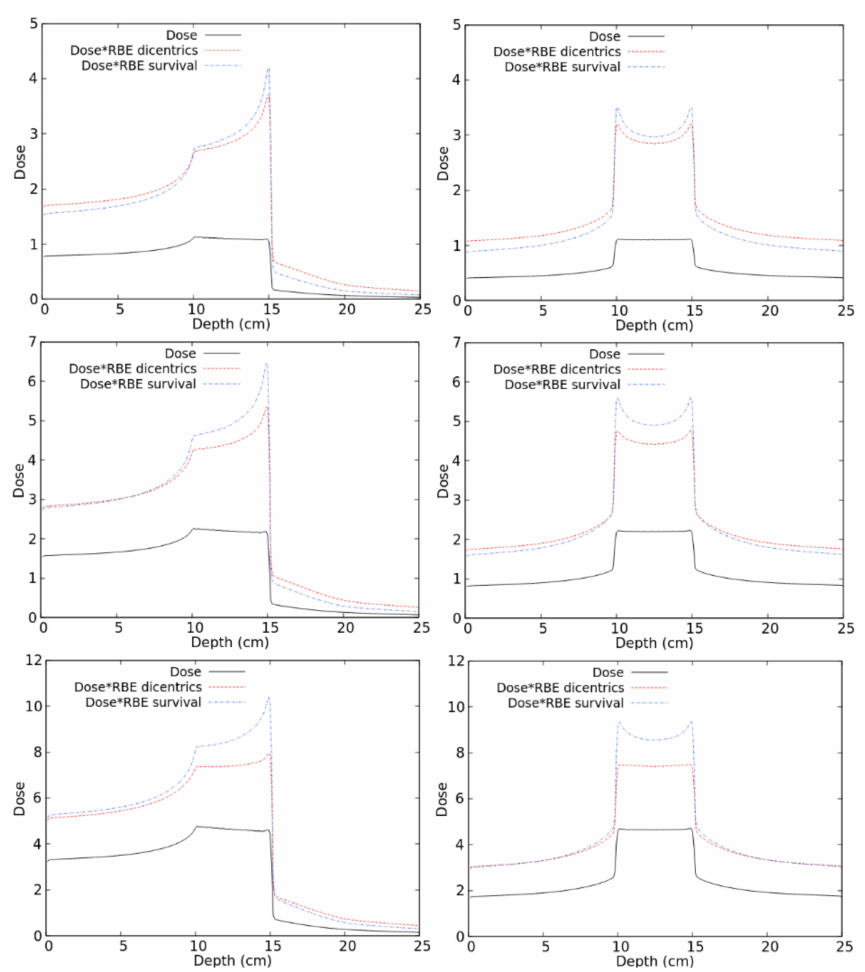
Figure 6. Distribution of absorbed doses and RBE-weighted doses (both for lymphocyte dicentrics and for cell death) for different C-ion fields as described in the